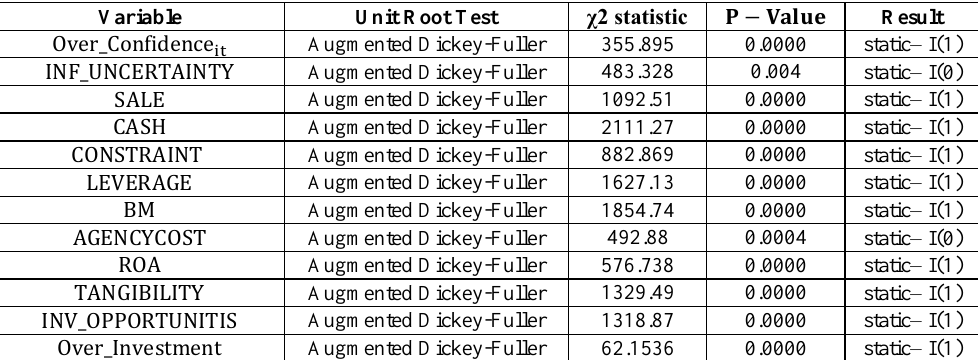
Table 3. Variable reliability test